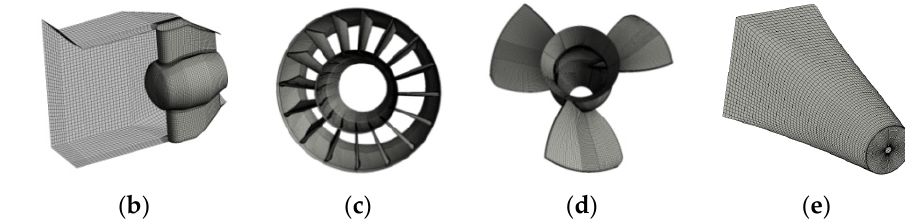
Figure 3. Calculation of catchment grid: ( a ) Global domain grid; ( b ) bulb body; ( c ) guide vane; ( d ) runner; ( e ) draft tube.